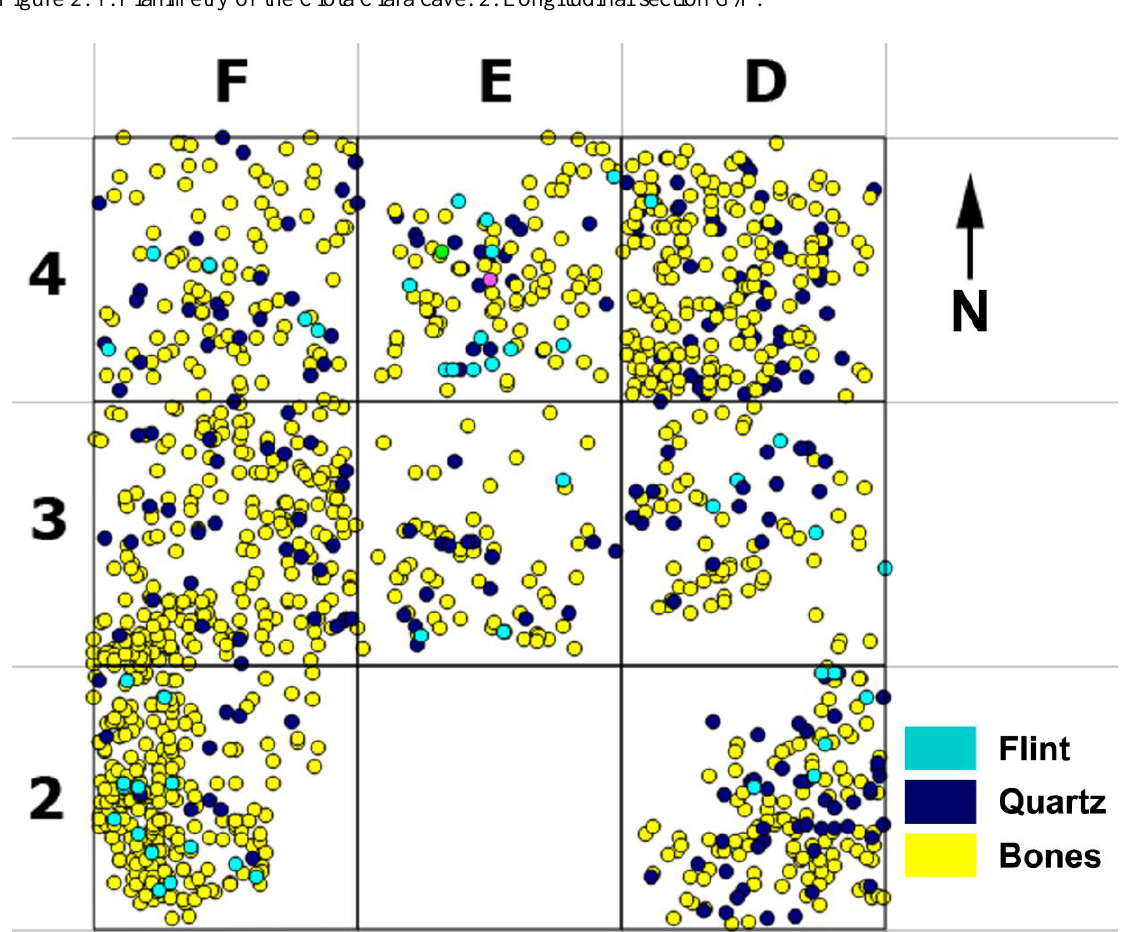
Figure 3. The Ciota Ciara cave spatial distribution of coordinate objects from the SU 14 (excavation 2013). 1 metre